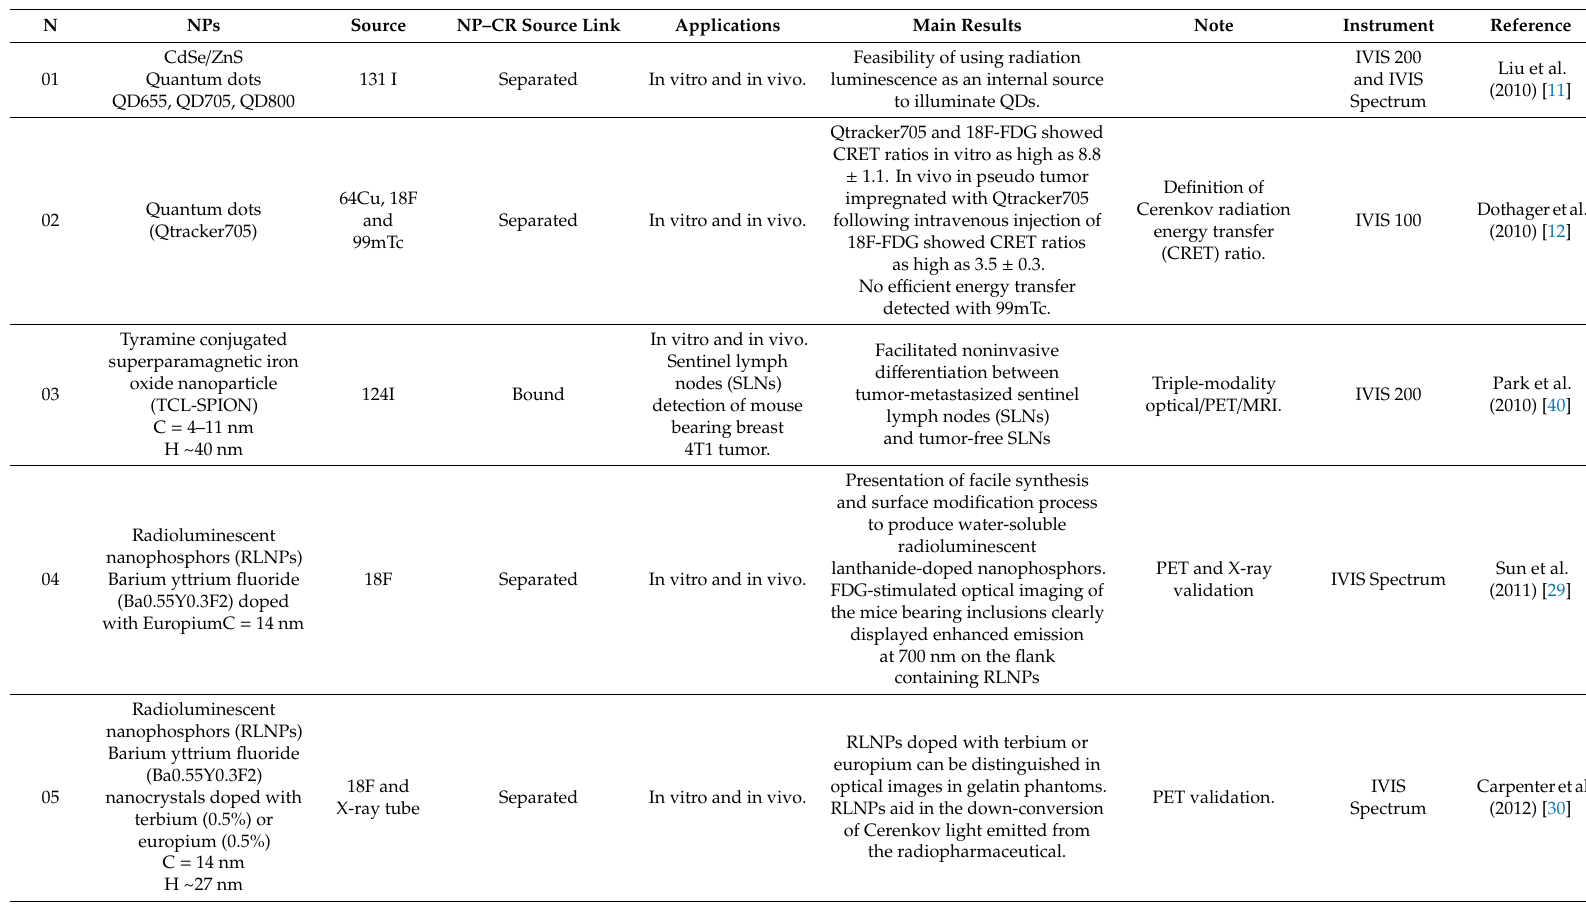
Table 1. List of studies reporting the interactions between Cerenkov sources and nanosized particles. Briefly, the information reported in the columns is: progressive number (1), nanoparticles tested (2), Cerenkov radiation used to excite the nanoparticles (3), type of link between CR source and NPs (4), application of the study (mainly in vitro, in vivo, ex vivo) and cell lines in case of cancer imaging / therapy (5), main results of the study (6), notes (7), optical instrument used (8), reference (9). For an exhaustive explanation, see the main